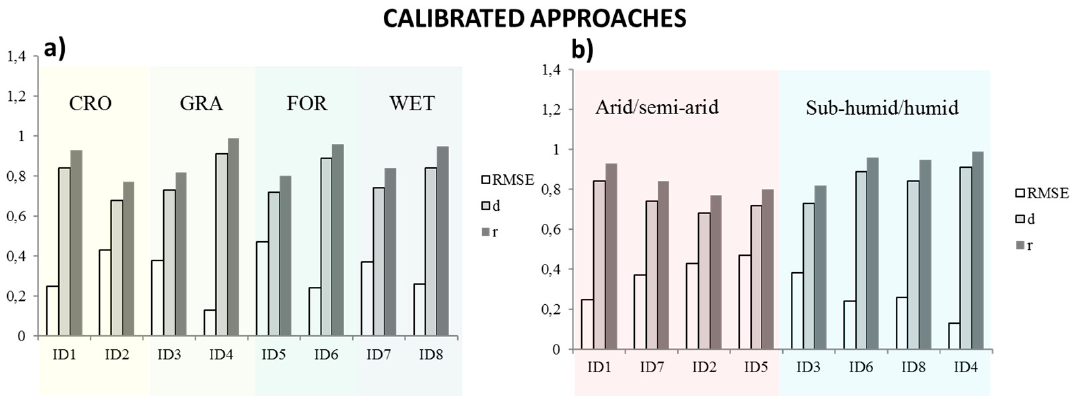
Figure 8. Goodness-of-fit indices for the most accurate model and for all the sites in case of calibrated approaches. Reference is made to ( a ) land cover (CRO, GRA, FOR, WET that respectively stand for cropland, grassland, forest, and wetland) and to ( b ) the moisture index I M (arid/semi-arid versus sub-humid/humid, ID numbers are sorted for increasing I M ).